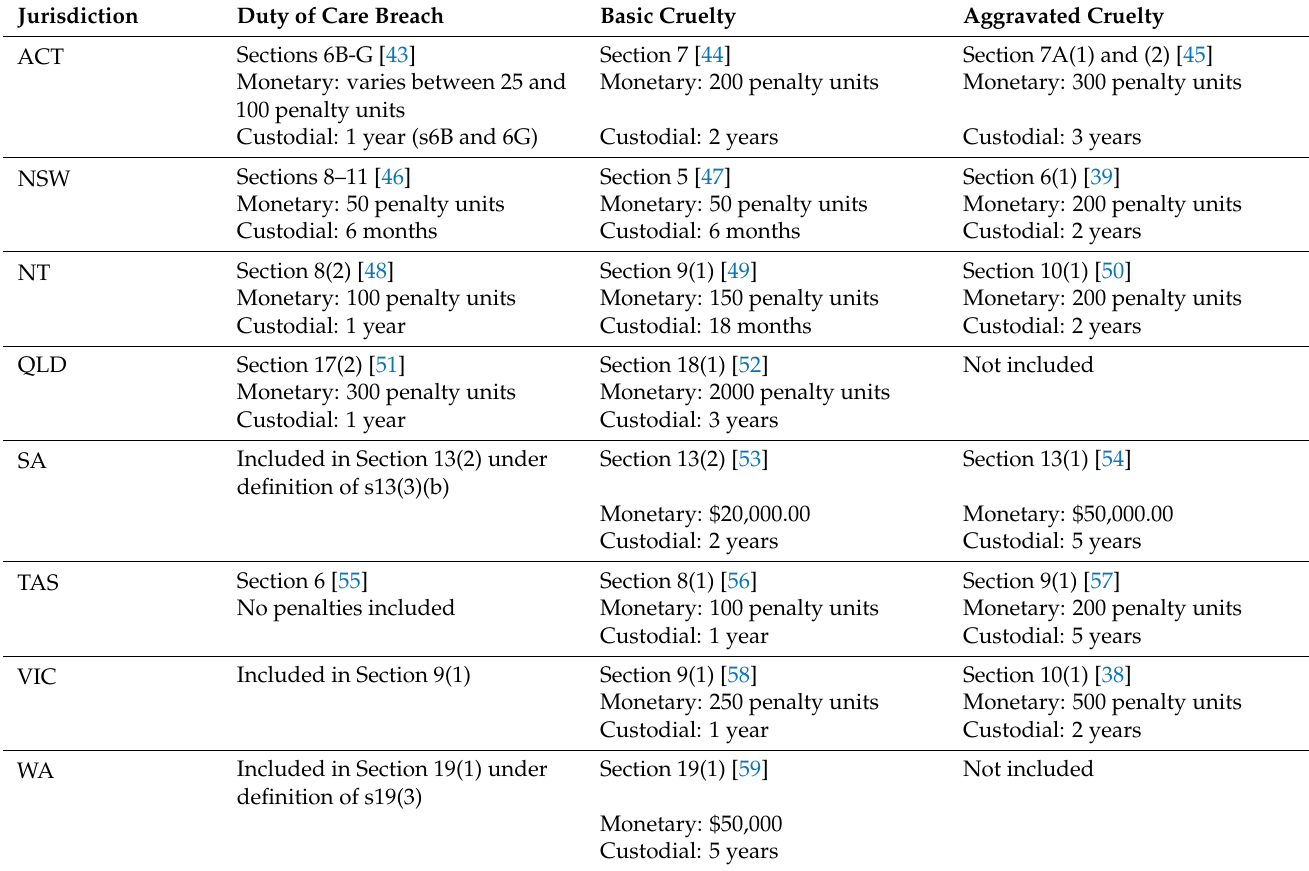
Table 5. Each animal welfare offence and the corresponding maximum penalties per each state and territory’s animal welfare act. Penalties are applicable to natural persons; separate penalties apply for body